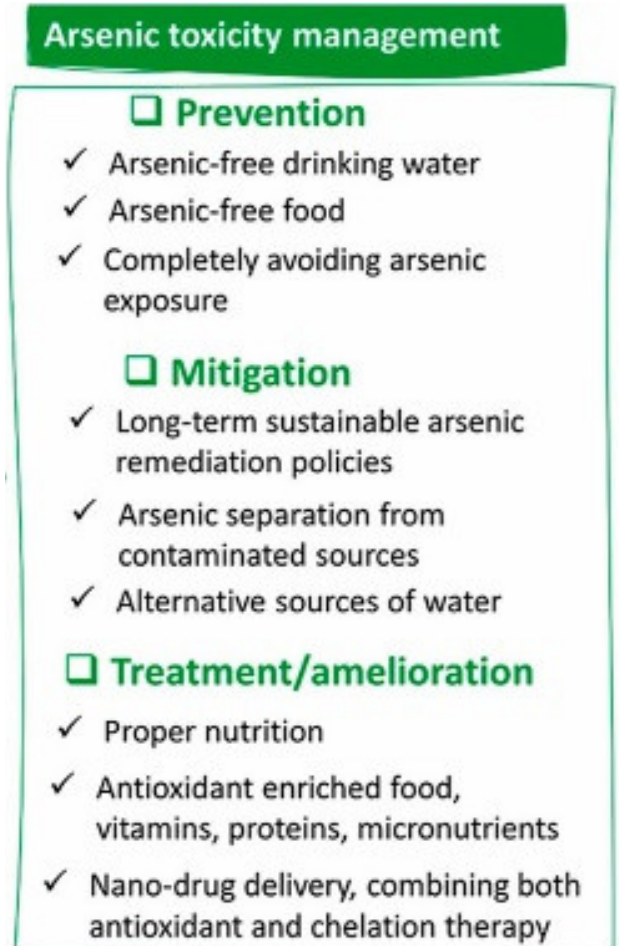
Figure 5. Arsenic toxicity management. Figure 4. Arsenic toxicity